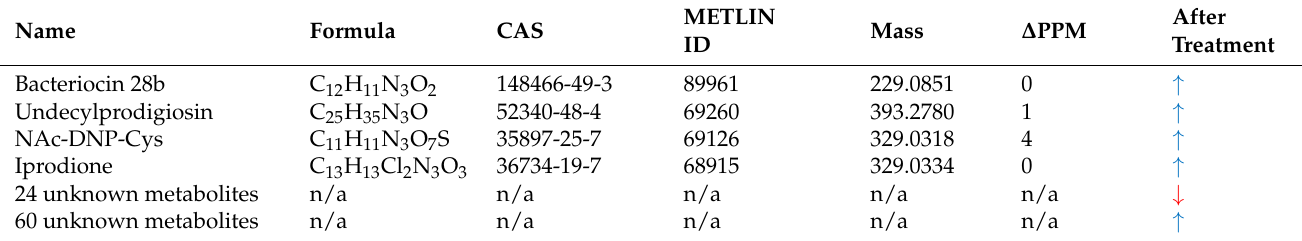
Figure 3. 6S/nLNP treatment alters fecal metabolites. ( a ) Representative UPLC-MS (ESI+, Q-TOF) total ion current (TIC) profiles of fecal metabolites before (day 0) and after (day 5, day 15) 6S/nLNP treatment. ( b ) Cloud plot demonstrating upregulated MS features (green; 1590 of 1844) and downregulated MS features (red; 254 of 1844) after five days of 6S/nLNP treatment (day 15 sample). ( c ) Venn diagram of disappeared or appeared fecal metabolites before and after 6S/nLNP treatment, as detected by LC-MS. Twenty-four metabolites disappeared and 60 new metabolites appeared after 5 days of treatment (day 15 sample). ( d ) Heatmap summary of the numerous significantly upregulated metabolites on day 15 induced by a five-day 6S/nLNP treatment and their possible molecular weights (MW.). Table 1. Part of tentatively identified major fecal metabolites before and after 6S/nLNP